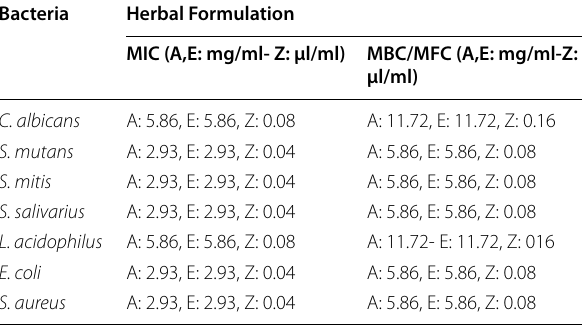
Table 3 MIC, MBC, and MFC of the formulation